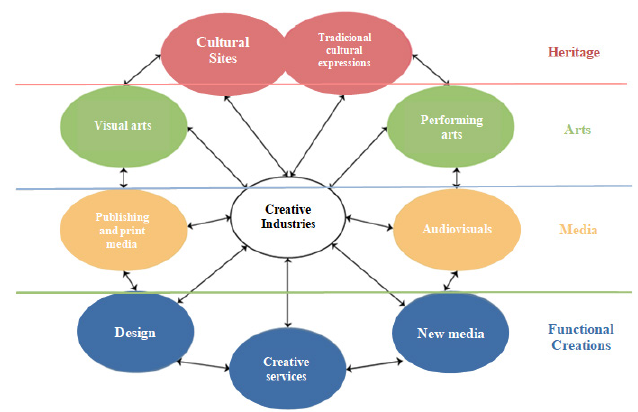
Figure 1. Classification of creative industries (source: created by authors with a base on United Nations Conference on Trade and Development,